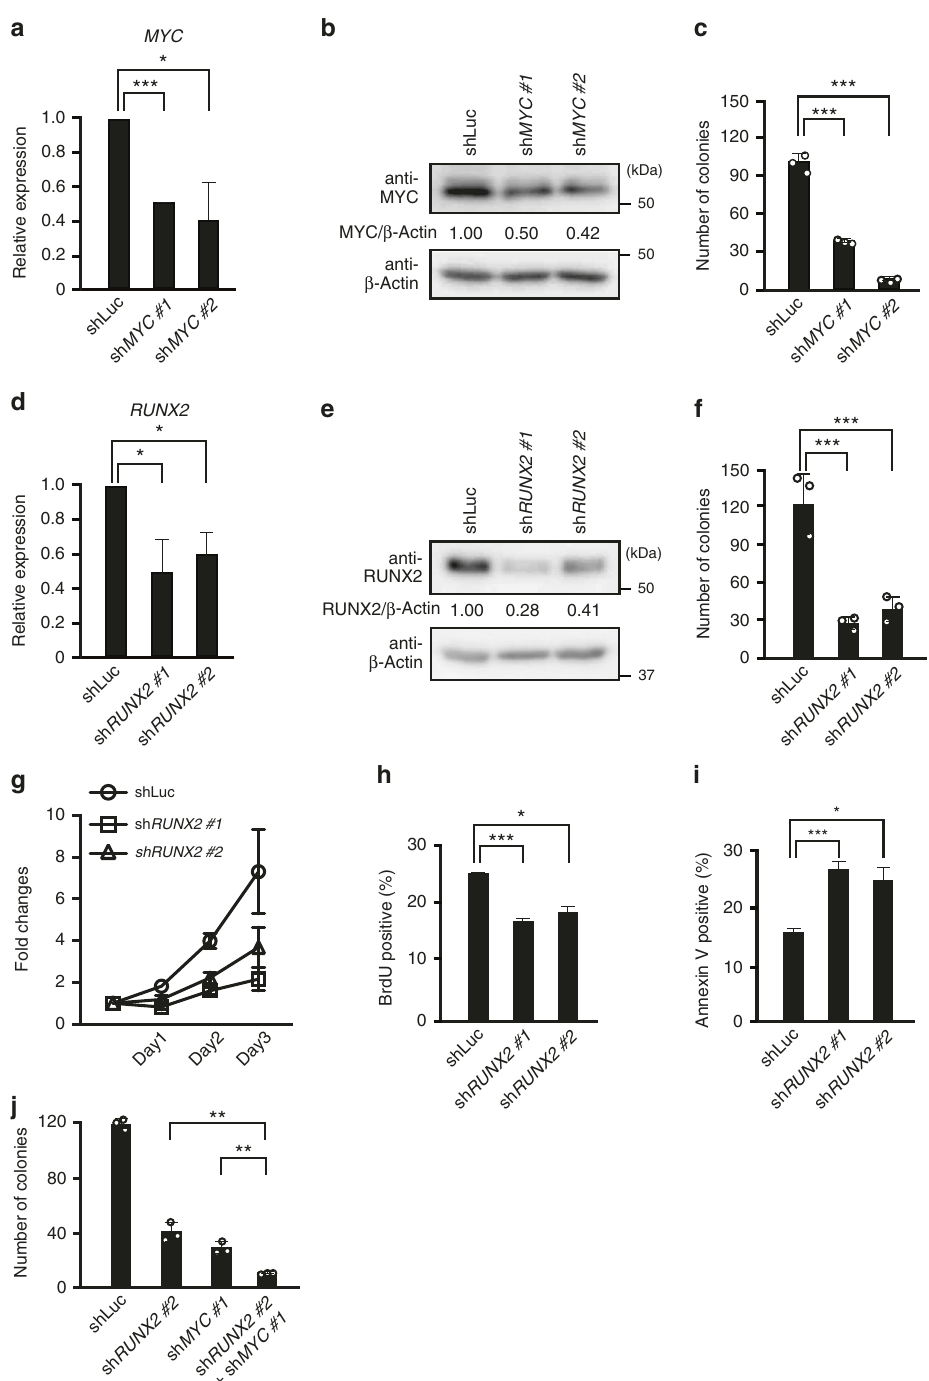
Fig. 2 MYC and RUNX2 collaborate to promote the formation of BPDCN cells. a Expression levels of MYC mRNA in CAL-1 cells transduced with two distinct MYC-directed shRNA vectors and a control luciferase-directed shRNA vector. b Expression levels of the MYC protein in MYC KD CAL-1 cells. Levels of β -Actin were used as loading controls. c Impaired colony formation capacities in MYC KD CAL-1 cells from those in control cells ( n = 3). d Expression levels of RUNX2 mRNA in CAL-1 cells transduced with two distinct RUNX2 -directed shRNA vectors and a control luciferase-directed shRNA vector. e Expression levels of the RUNX2 protein in RUNX2 KD CAL-1 cells. Levels of β -Actin were used as loading controls. f Impaired colony formation capacities in RUNX2 KD CAL-1 cells from those in control cells ( n = 3). g Decreased cell growth in RUNX2 KD CAL-1 cells (squares and triangles) under in vitro liquid culture conditions from that in control CAL-1 cells (circles) ( n = 3). h Reduced proliferative capacities in RUNX2 KD CAL-1 cells assessed by BrdU incorporation ( n = 3). i Enhanced apoptosis in RUNX2 KD CAL-1 cells over that in control CAL-1 cells ( n = 3). j Reduced colony formation capacity in MYC and RUNX2 double KD CAL-1 cells from those in single KD cells ( n = 3). a , c , d , f , g – j Bars show the mean±SD, * p < 0.05, ** p < 0.01, and *** p < 0.001 by the Student ’ s t -test. Data are representative of 2 – 3 independent